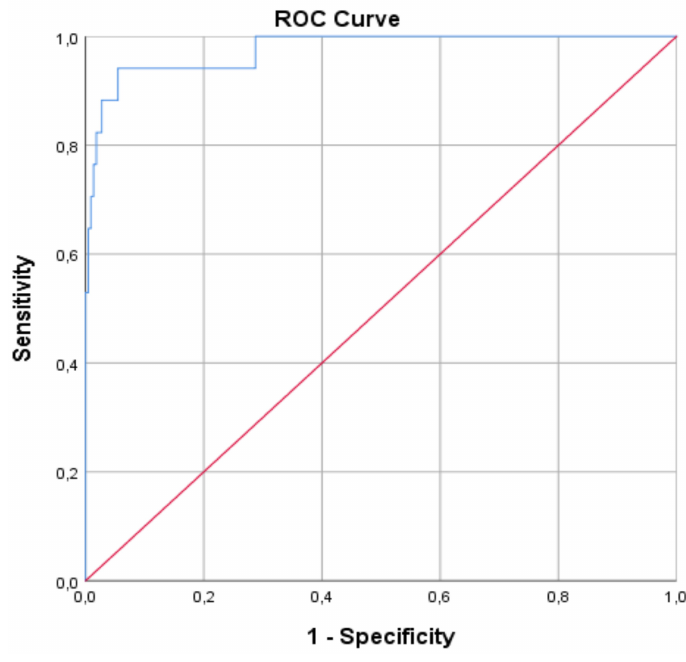
Figure 2. ROC curve.